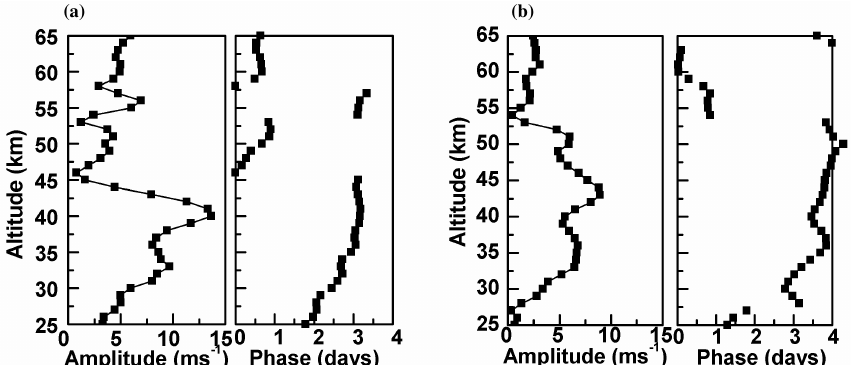
Fig. 4. Vertical profile of amplitude and phase of 4-day wave (a) zonal wind and (b) meridional